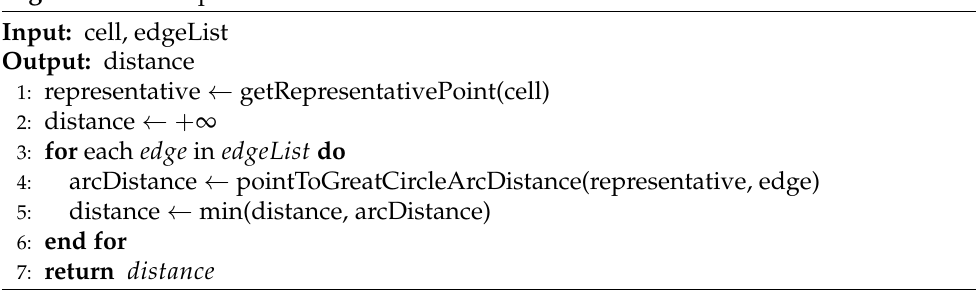
Algorithm 3 Compute Distance.